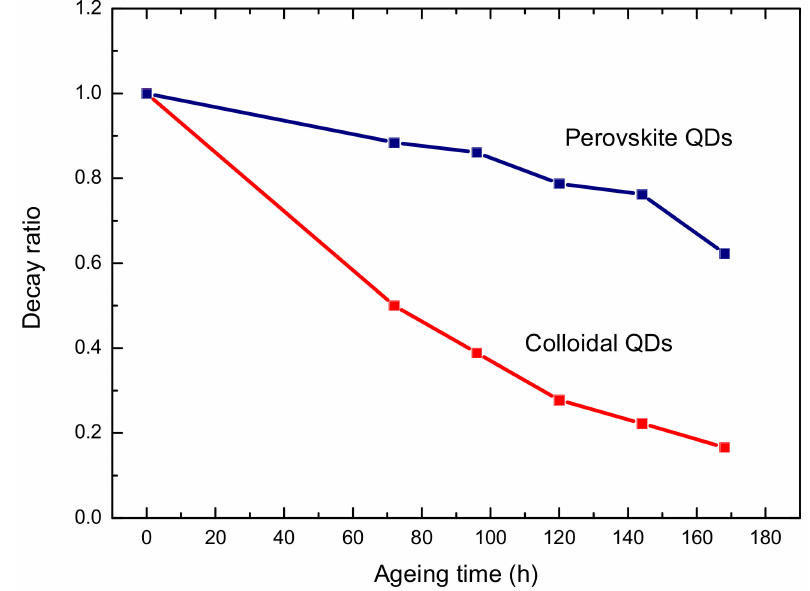
Figure 1. Ageing test of perovskite and colloidal of quantum dots (QDs) using photoluminescence.